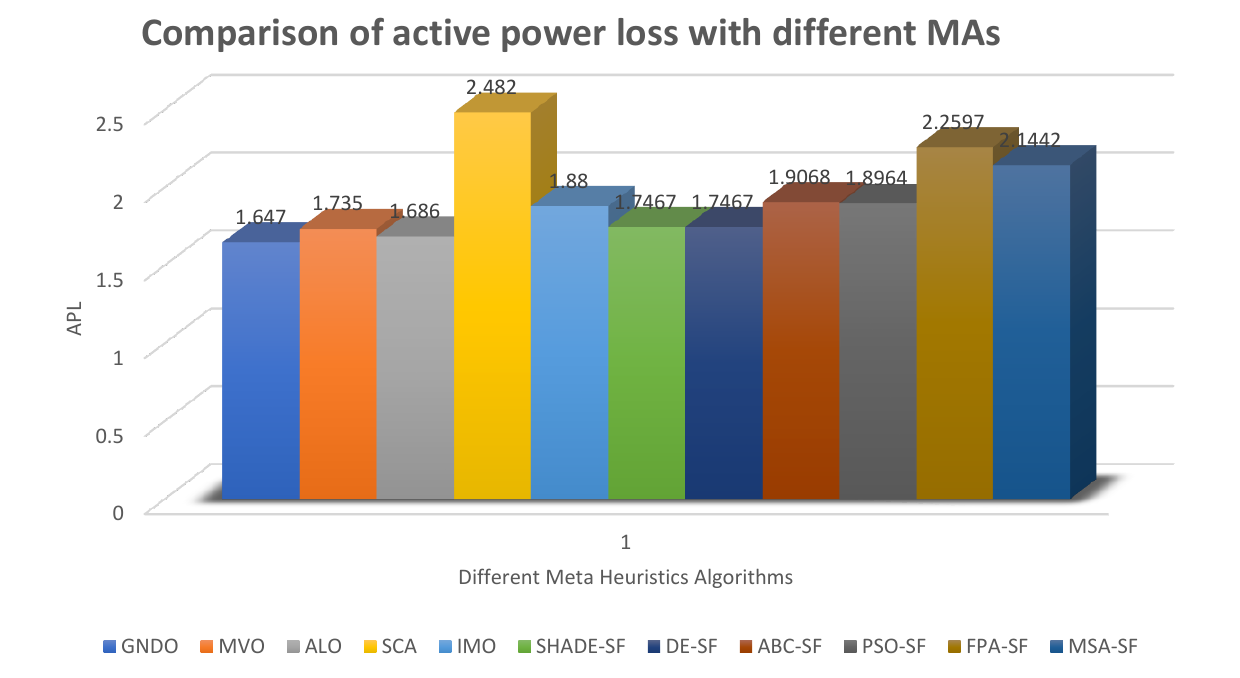
Figure 19. Comparison chart for APL minimization with different algorithms.